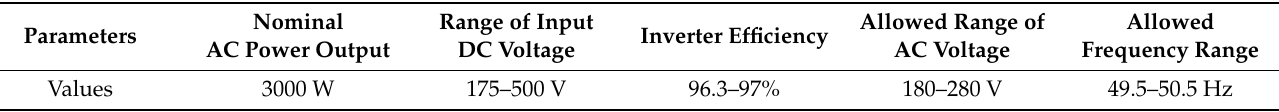
Table 2. Main electrical specification of the installed grid-tie Inverter (SMA Sunny Boy-3000).